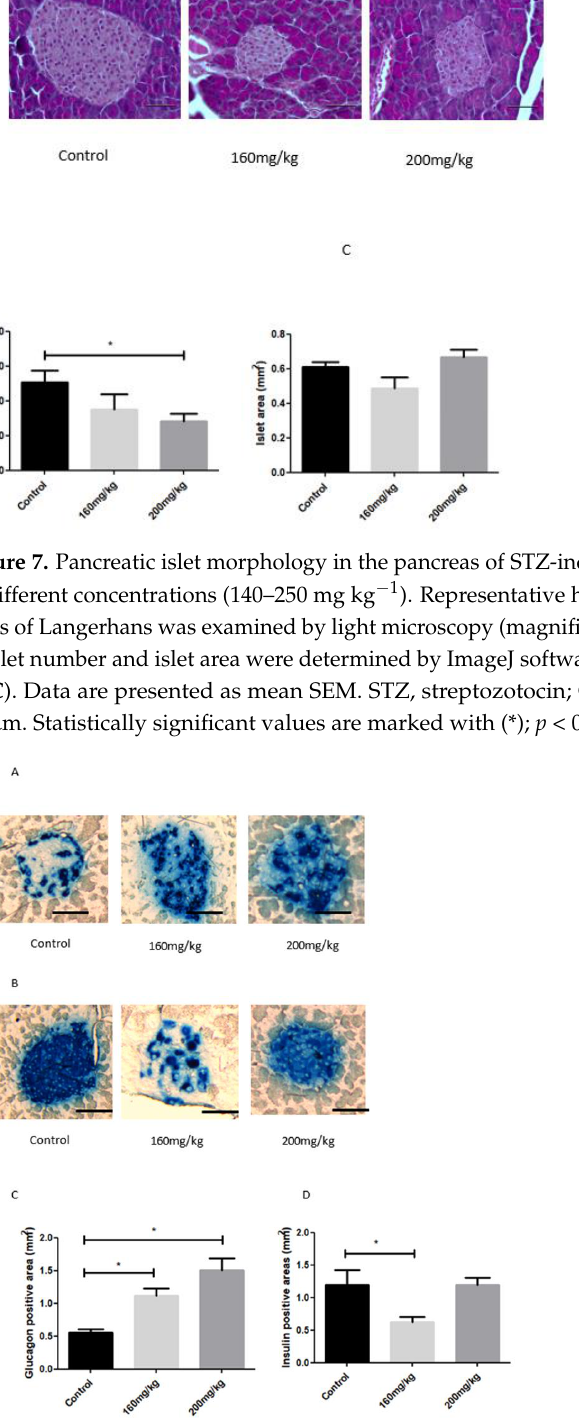
Figure 8. Insulin and glucagon production in the pancreas of STZ-induced diabetic mice treated with STZ at different concentrations (140 – 300 mg/kg). Insulin and glucagon staining of the islets of Langerhans examined by light microscopy are shown in blue ( A , B ). The quantifications of positive glucagon area and positive insulin area were determined by ImageJ software ( n = 3; n = 4; n = 6, shown in mm 2 ) ( C , D ). Data are presented as mean SEM, p -value < 0,05; Statistically significant values are marked with (*). STZ, streptozotocin; control non-treated mice. Scale bar: 20 µm.